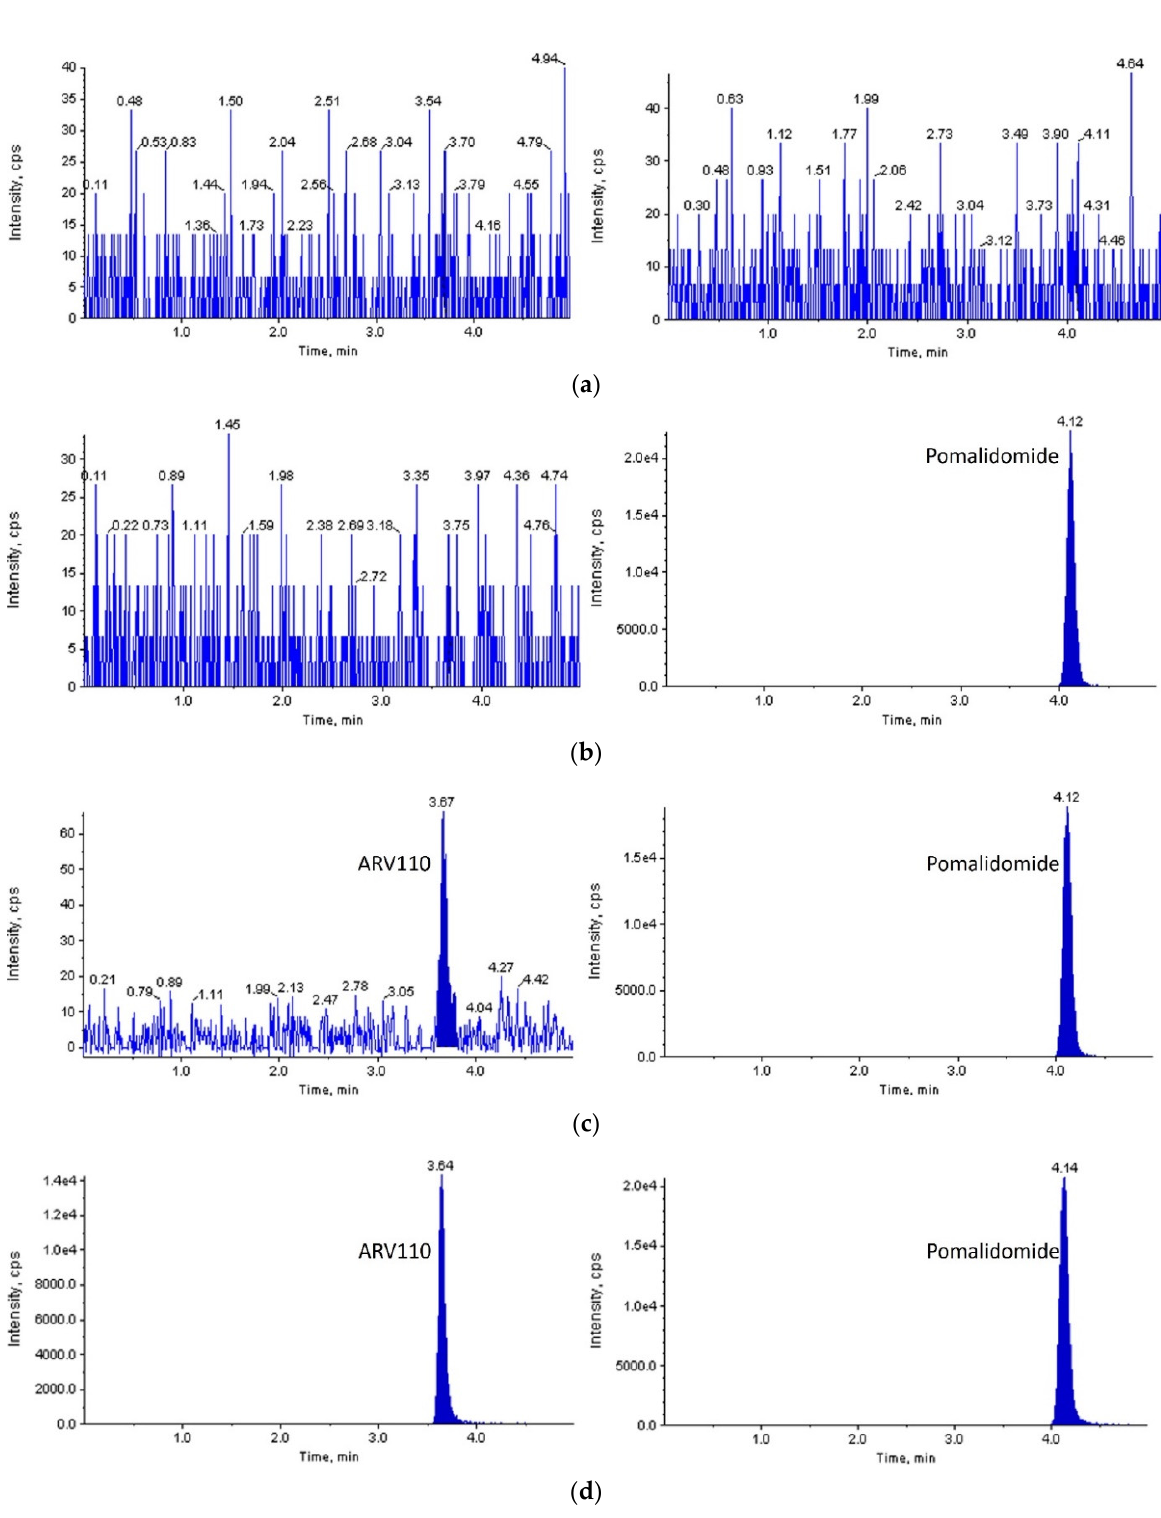
Figure 2. MRM LC-MS/MS chromatograms of ARV-110 (left) and pomalidomide (right) after depro- teinization of blank rat plasma ( a ); zero calibrator ( b ); LLOQ ( c ); and rat plasma sample 60 min after PO administration of ARV-110 at a dose of 2 mg/kg ( d ).